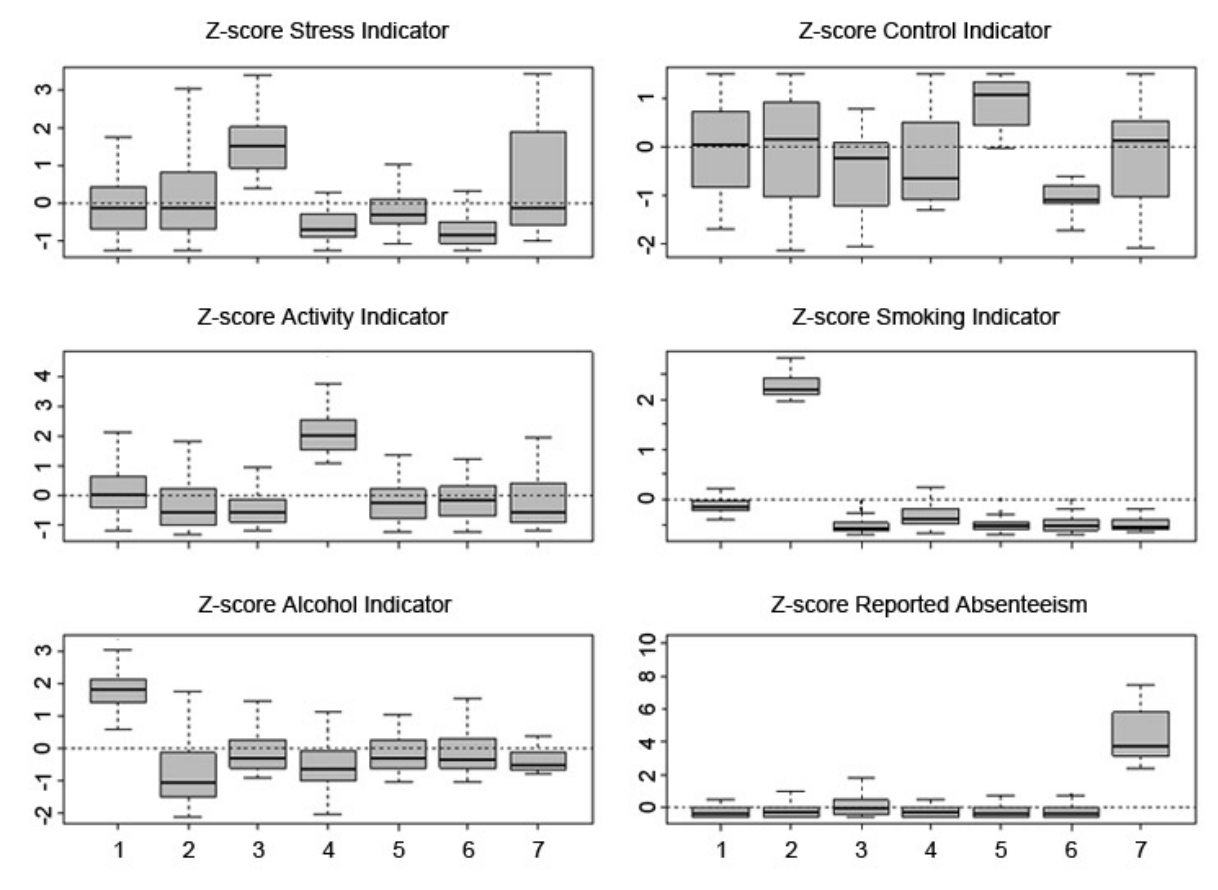
Figure 3. Boxplots of within-cluster distributions of standardized classification variables (x-axis: numeric cluster labels as given in Table